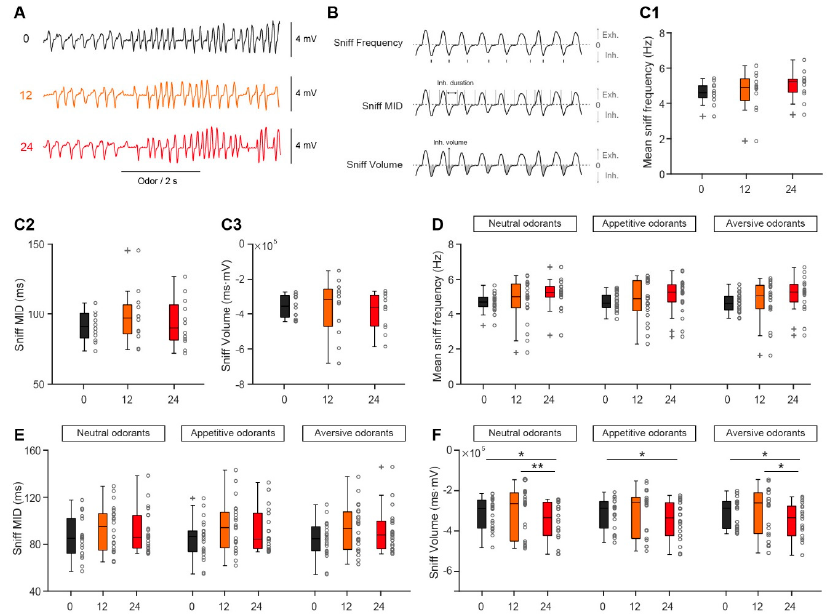
Figure 6. Change in the sniffing volume under different nutritional states. ( A ) Raw sniff trace recorded from a representative mouse fasted for 0 h (black), 12 h (orange), or 24 h (red). ( B ) Diagram illustrating the extraction of sniff frequency, mean inhalation duration (MID), and volume from a sample nasal flow trace. ( C ) Sniffing recorded under baseline conditions (no odor presentation) after fasting for different durations. C1 . Mean sniff frequency. One-way ANOVA: F (2,22) = 1.30, P = 0.29. C2 . Sniff mean inhalation duration (MID). Friedman’s test: χ 2 (2,22) = 2.17, P = 0.34. C3 . Sniff volume.